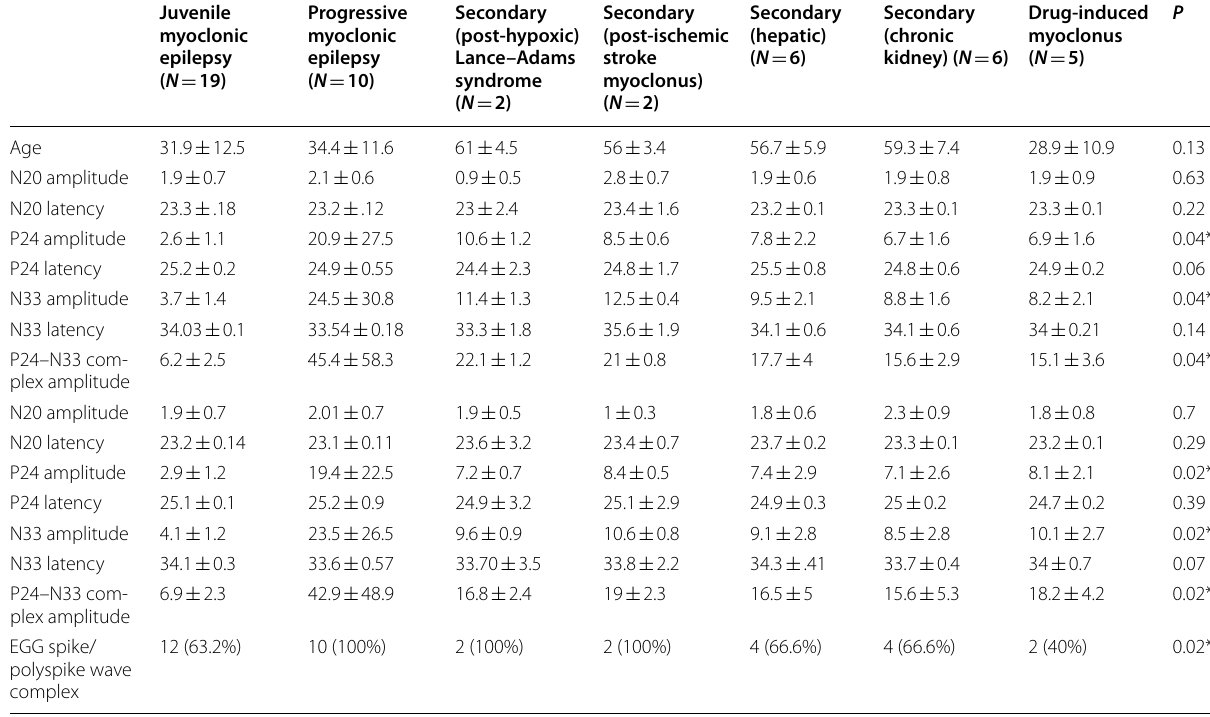
Table 4 SSEP in different myoclonic subgroups